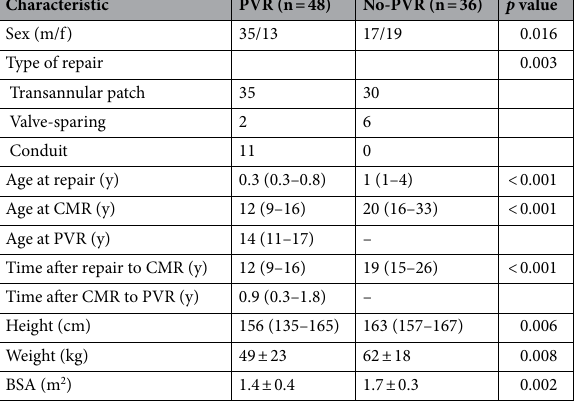
Table 1. Summary characteristics grouped by PVR status. Normally distributed data are reported as mean ± standard deviation or as median (interquartile range) otherwise. BSA Body surface area, CMR Cardiovascular magnetic resonance, PVR Pulmonary valve